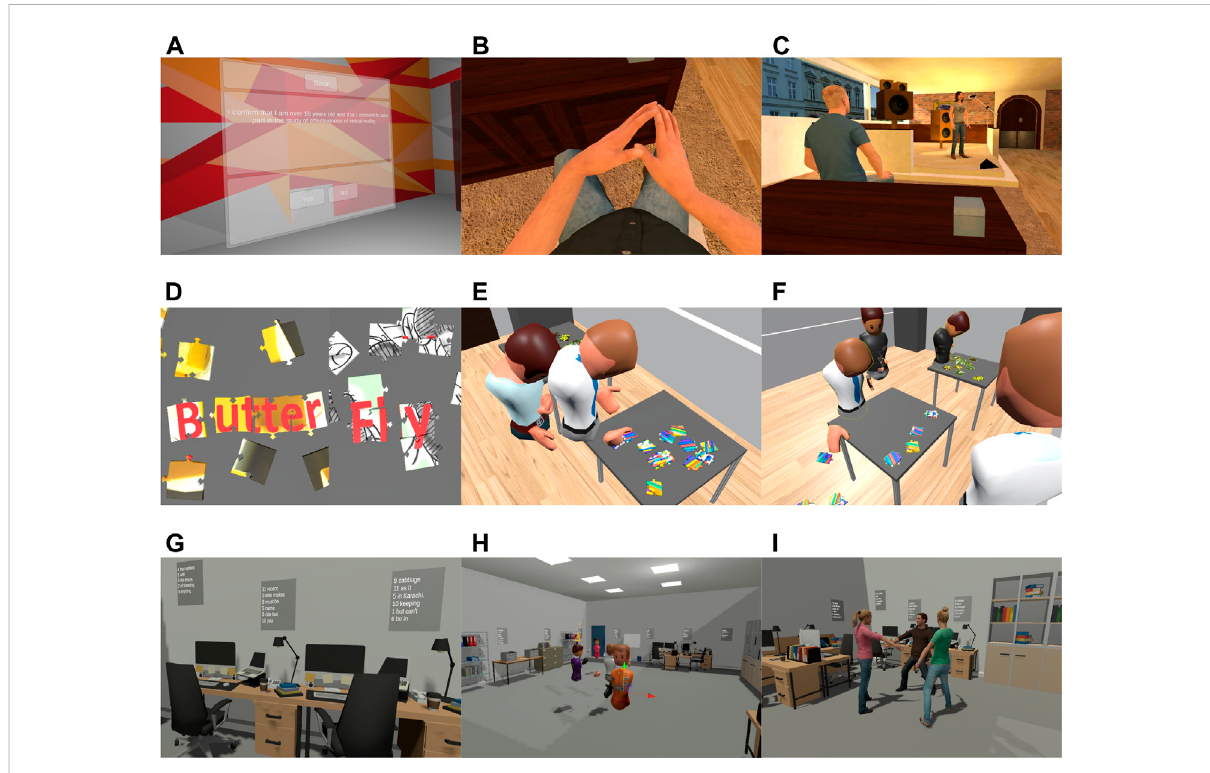
FIGURE 1 Imagesfromthethreeexperimentsandenvironments. (A) Oneofthequestionsinthepre-questionnaireforthesingerinthebarexperiment. (B) View of the male fi rst-person sat avatar with tracked hands. (C) View of the singer. (D) Two example jigsaw puzzles that reveal the compound word ‘ butter fl y ’ . (E) Oneparticipantisusinghisbodytoshieldthepuzzle. (F) Twoparticipantsarewatchingtheirreplays(avatarswithyellowoutlines)inVR. (G) Example of the word-puzzle posters. (H) View of the participants ’ and experimenter ’ s avatars. (I) A view of the same scenario, but using the RocketBox